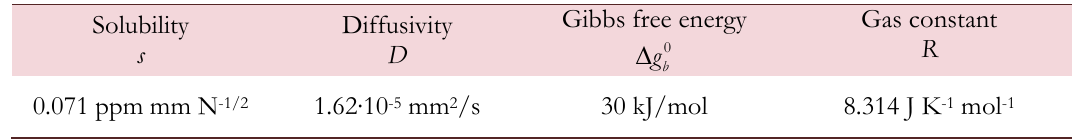
Table 1: Values of parameters adopted in the three simulations of the cohesive zone